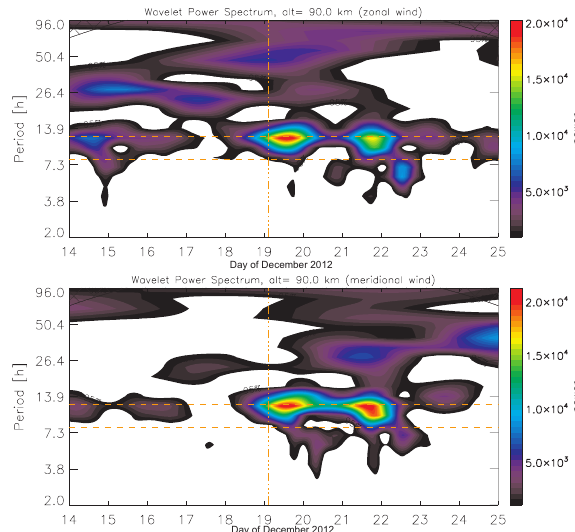
Fig. 6. The wavelet spectra of the the wind measured by the SAURA MF radar during December 2010. Upper panel: zonal wind. Lower panel: meridional wind. Horizontal orange lines mark 12 and 8h periods. Vertical lines mark launch time of ECOMA09 sounding rocket. Cross hatched areas mark cone of influence, i.e., uncertain part of the spectra affected by edge